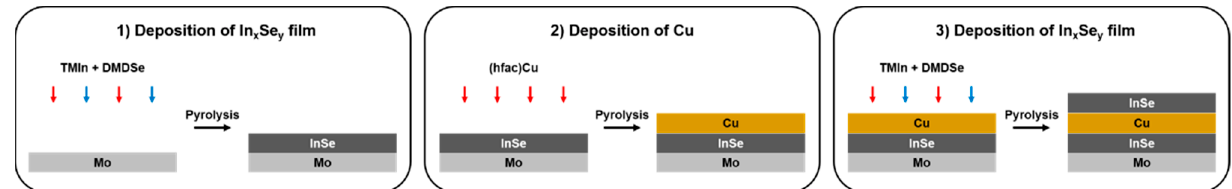
Figure 1. Schematic of the three-step MOCVD process for CIS layer deposition.